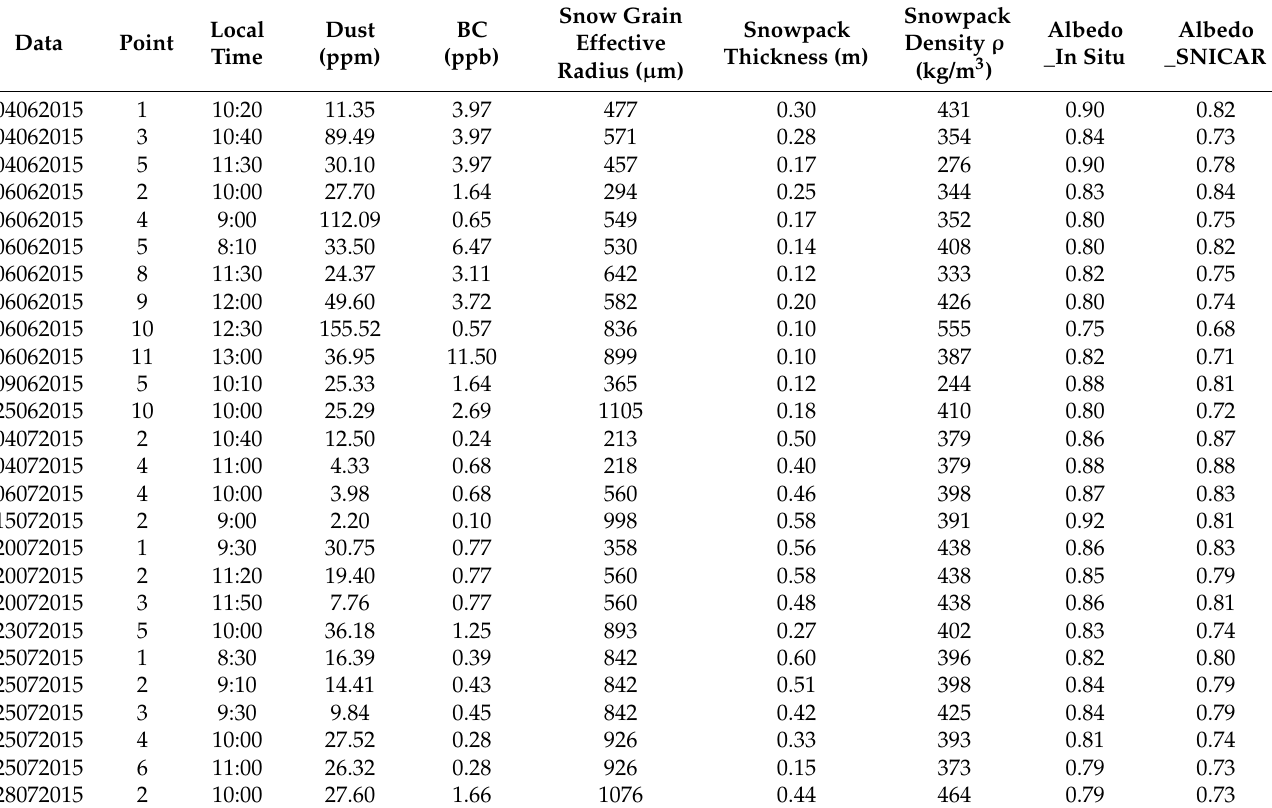
Table 1. Comparison of the measured albedo with simulated albedo for the QT No. 1 Glacier in